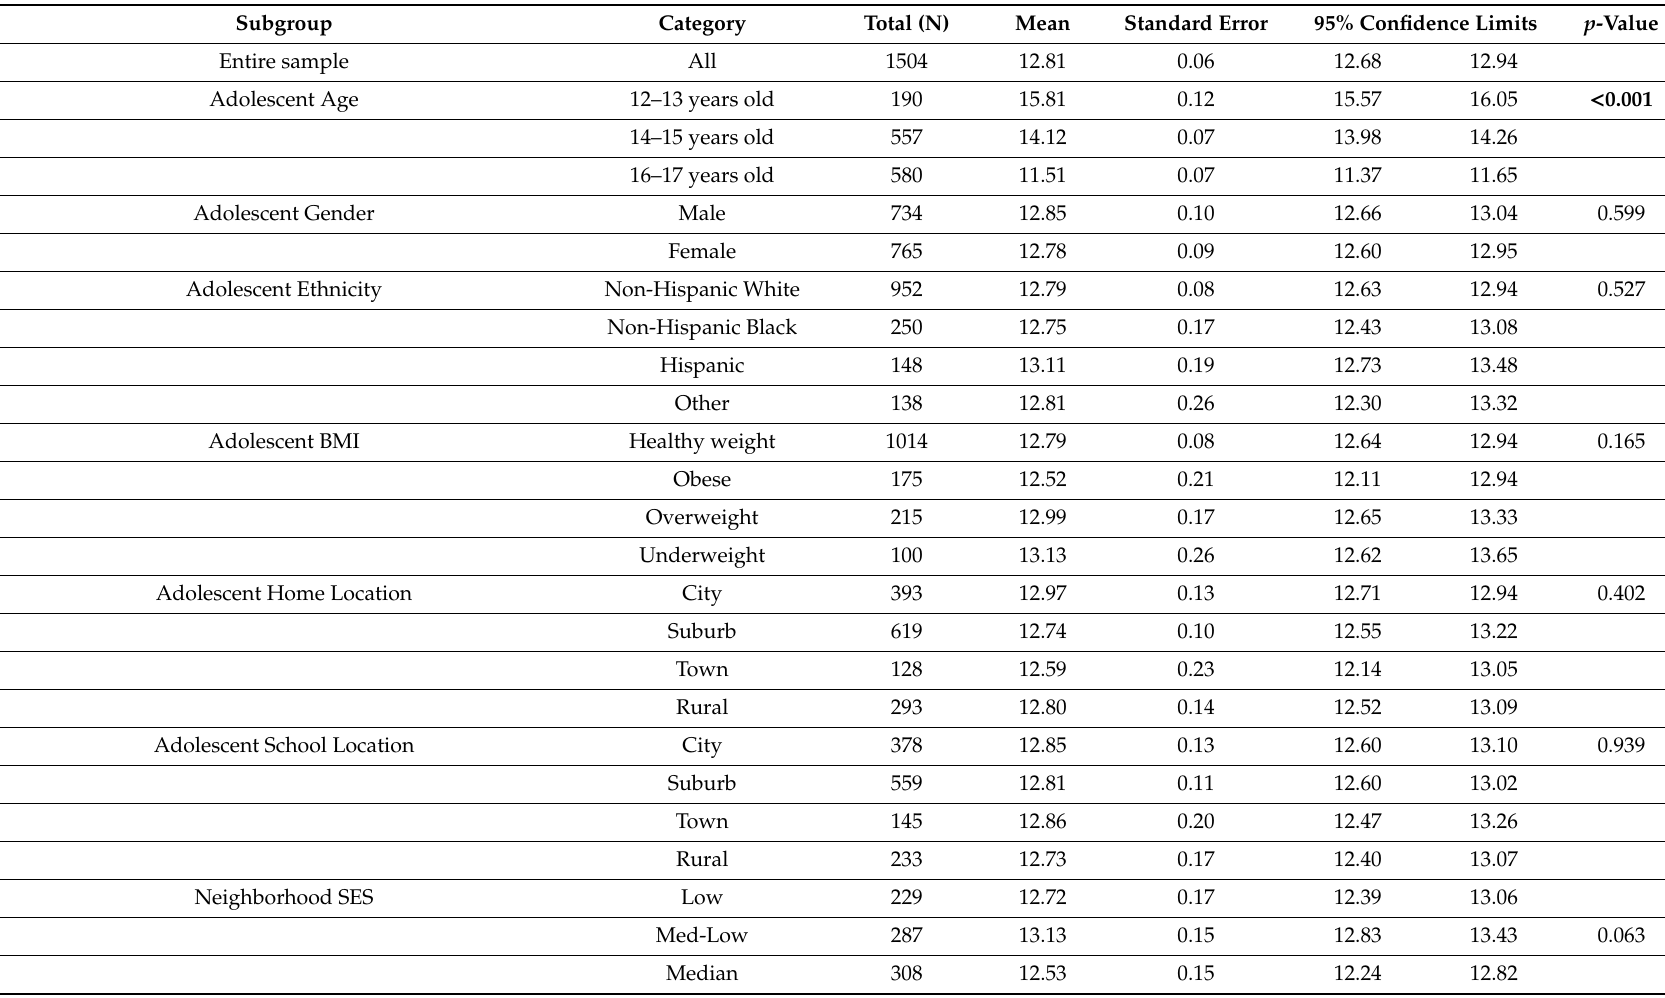
Table 1. Summary of the sample and the bivariate association with adolescents’ physical activity (PA) levels (total hours of PA in school, out-of-school, and on